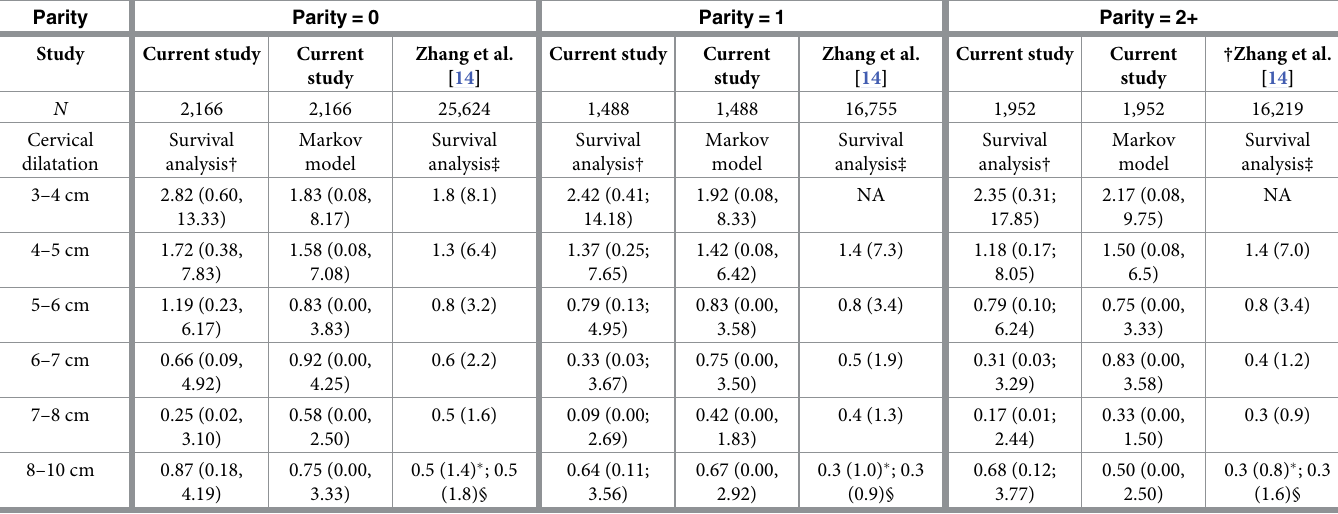
Table 2. Duration of labour from one level of cervical dilatation to the next by parity and analysis method. Parity Parity = 0 Parity = 1 Parity =